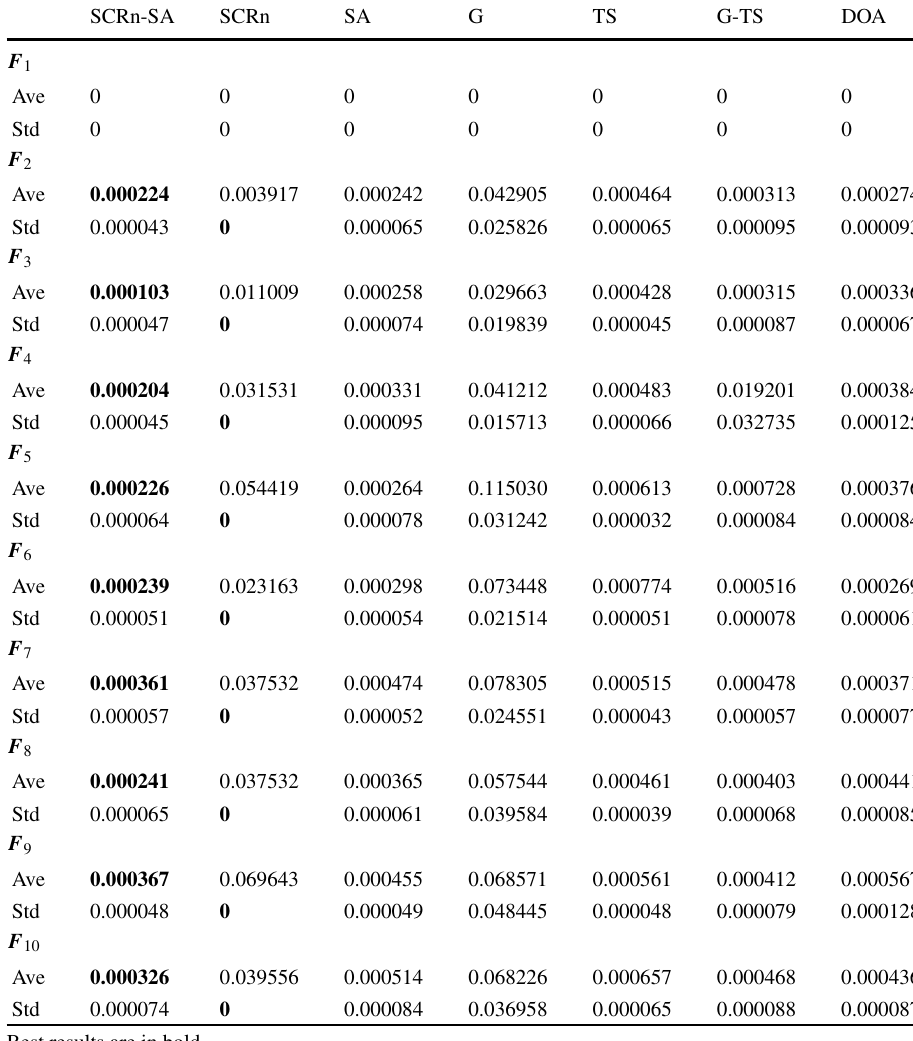
Table 6 Statistical results of SCRn-SA, SCRn, SA, G, TS, G-TS and DOA on real scenes